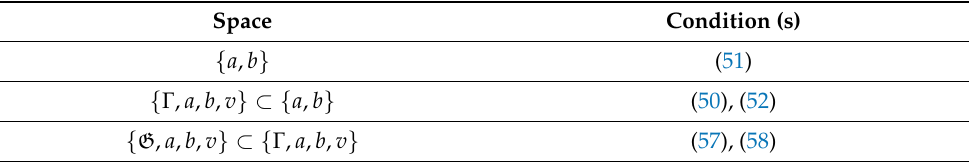
Table 1. Spaces of real-analytic